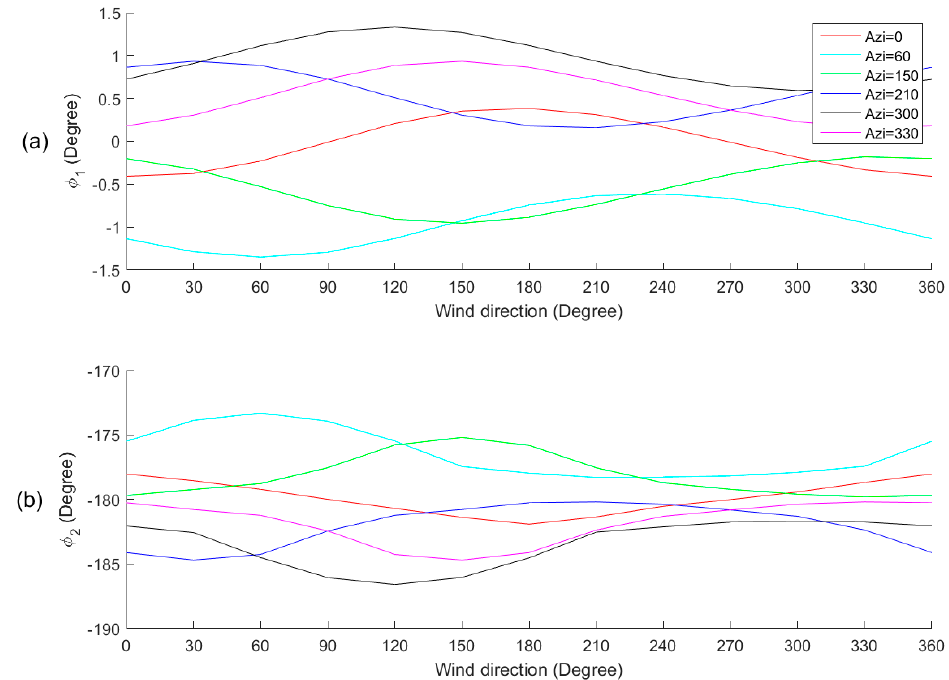
Figure 6. The influence of the receiver’s azimuth on the relation between wind direction and the angles of ( a ) ϕ 1 and ( b ) ϕ 2 . The wind speed and the receiver’s elevation are 15 m/s and 75 ◦ .